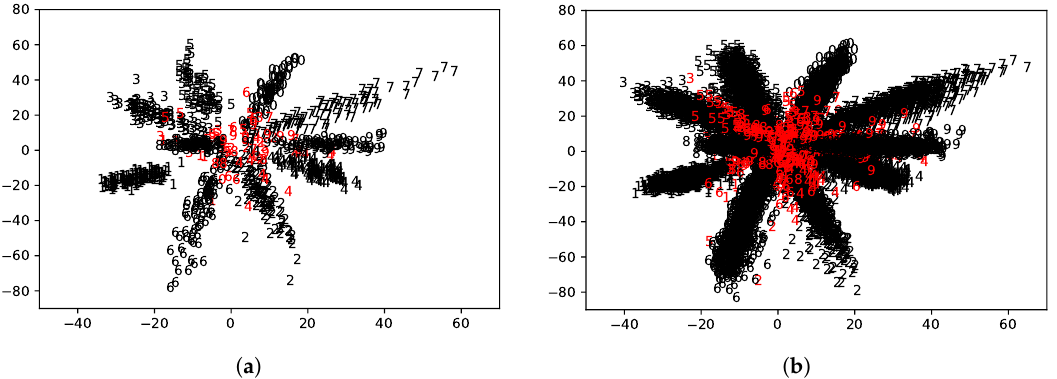
Figure 2. 2D embedding of the learned features for the ANN is displayed. For better visibility, the left figure shows only the first 1000 samples in the test dataset. Correctly classified digits are colored in black, whereas misclassified ones are in red. ( a ) First 1000 samples in the test dataset; ( b ) entire sample of the test